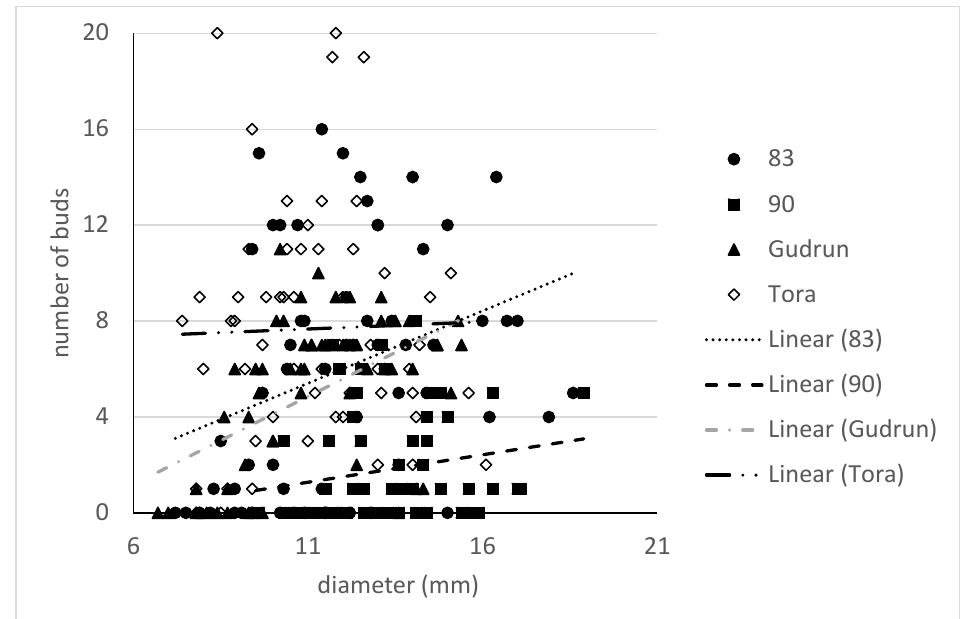
Figure 6. Relationship between the number of visible buds on the cuttings and cutting total biomass production for different clones in 2010.